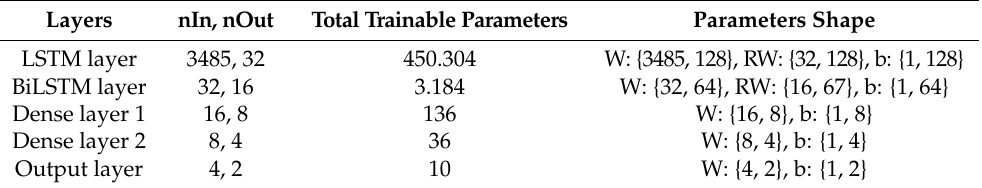
Table 1. RNN-Based Deep Learning (RNNBDL) neural network model.